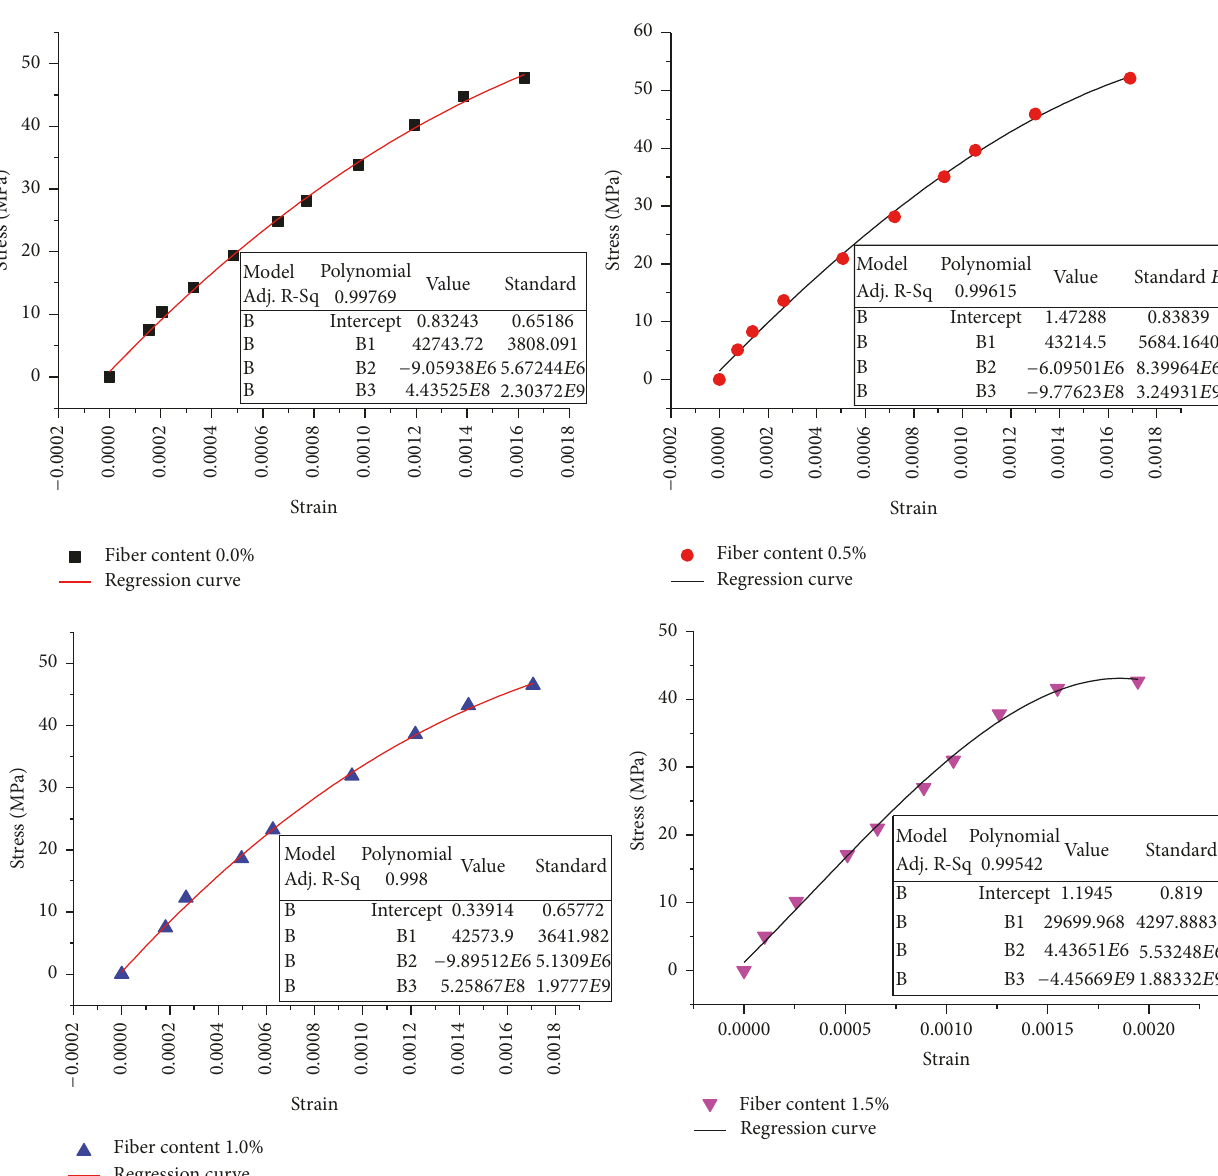
Figure 7: Regression curve of the compressive stress-strain ascending segment of fiber reinforced